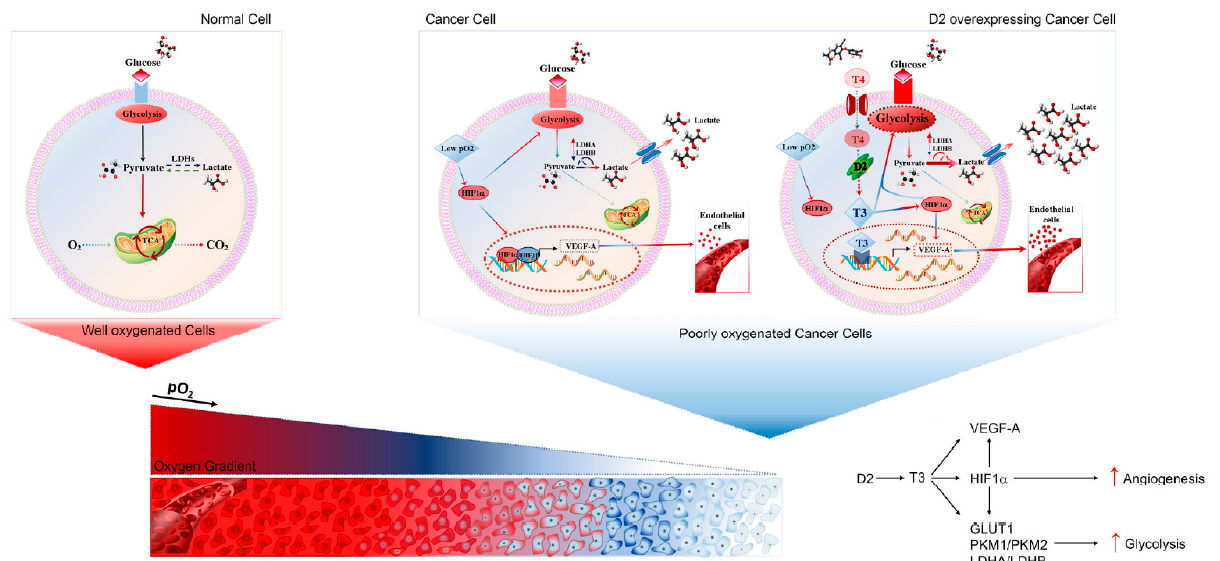
Figure 7. TH exerts a pro-angiogenic and pro-glycolytic function in cancer cells. Graphical representation of the TH–VEGF- A–HIF1 α regulatory axis in cancer cells during hypoxic conditions.